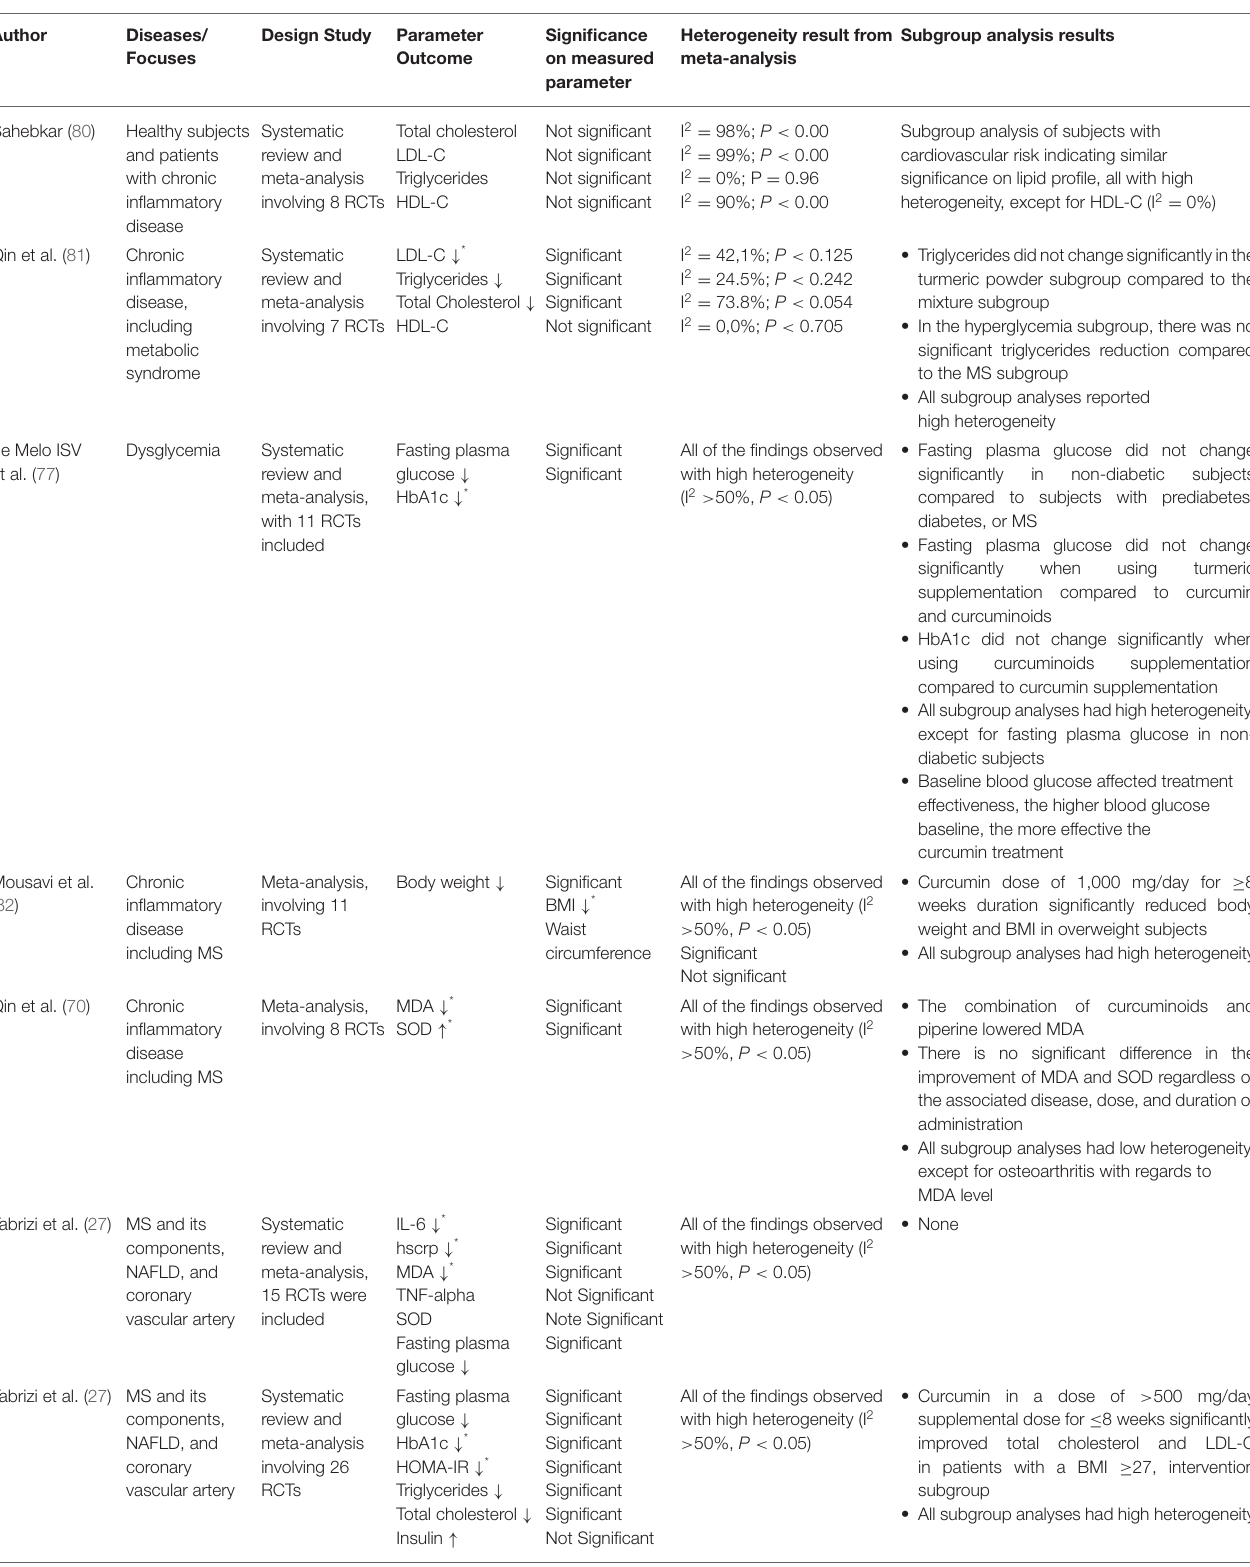
TABLE 2 | Meta-analysis of RCT of curcumin, curcuminoids, or turmeric in patients with triggering components in the origin of the MS (27, 28,